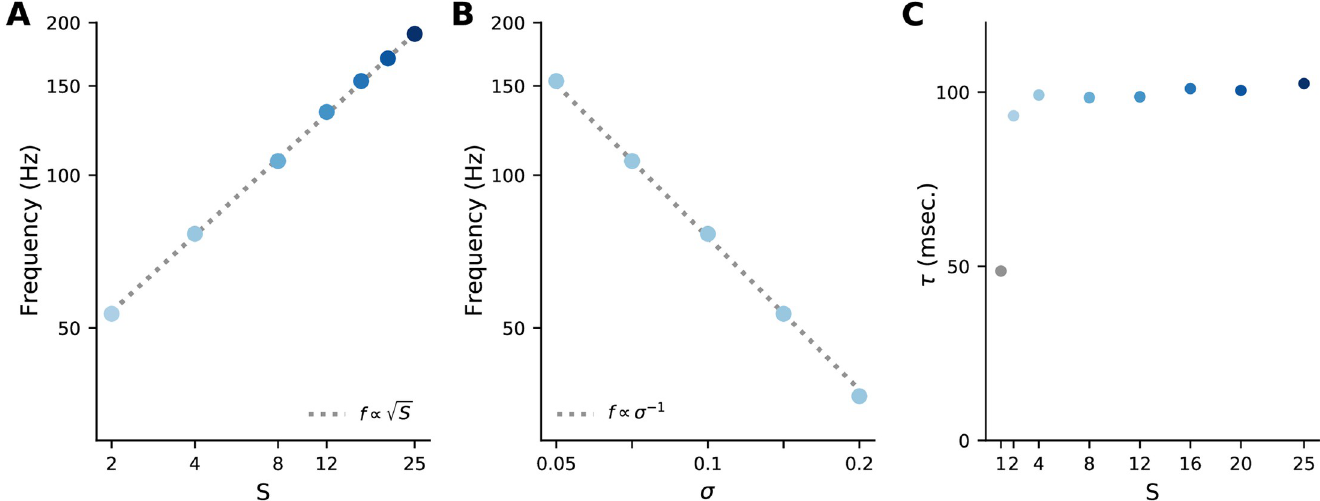
Fig 8. Transient properties of inference dynamics. (A) Dependence of the high-frequency mode of the mitral cell responses on the number of sisters, S . (B) Dependence on the standard deviation of the noise, σ . In both panels, the dashed lines are fits predicted by the linear analysis. (C) Dependence of the mitral cell decay time constant on the number of sisters S . Going from S = 1 to S = 2 sisters per glomerulus decreases the decay time constant by a factor of about 2. A large change in decay rate from S = 1 to 2, followed by a slower change for S � 2, is typical, although the details are parameter-dependent. Other parameters as in Table 1.